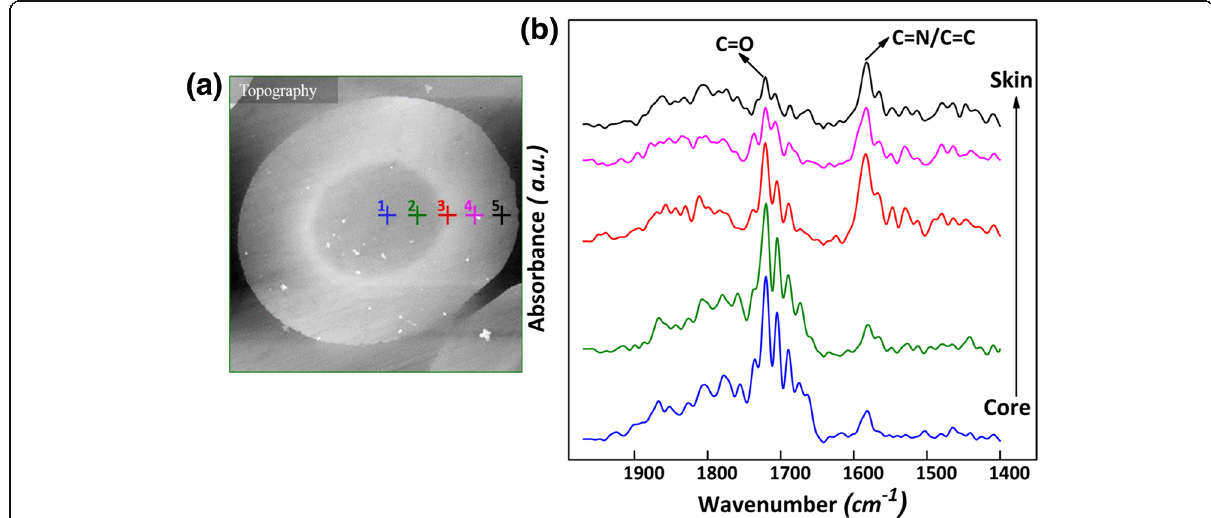
Fig. 2 a Topography image of sample 03; b The spectra in 1400 – 1900 cm − 1 of different points along radial direction